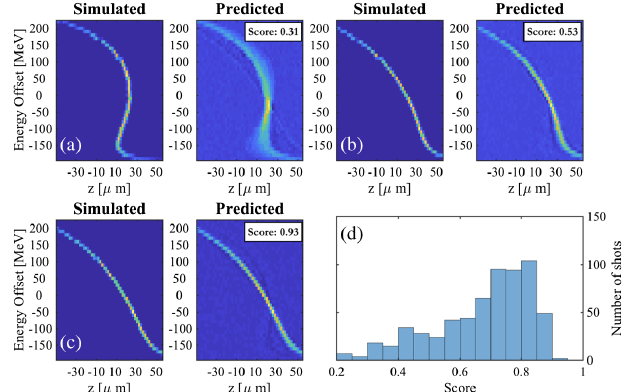
FIG. 3. (a) – (c) Simulated and predicted 2D LPS distributions for FACET-II. The predictions are outputs of a NN with 11 scalar valued nondestructive diagnostic inputs (see Table I). Case (a) represents an imperfect prediction with noticeable blurring and some visual artifacts. Cases (b) and (c) represent average to good predictions and show good agreement with the LPS distribution. (d) Histogram of the prediction accuracy in the test set quantified by the score ( R 2 coefficient of the LPS prediction). The mean score is 0.68, and 85% of the shots are above a score of